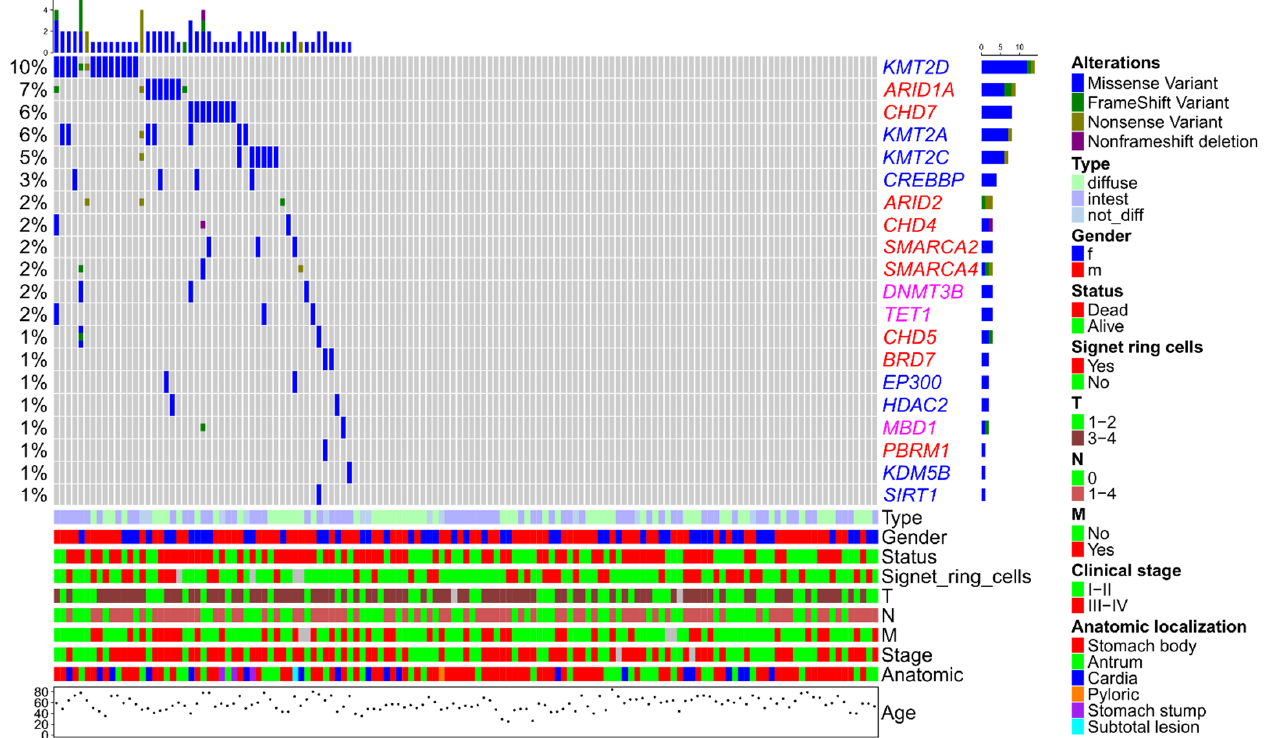
Figure 1. Spectrum of epigenetic regulation genes somatic mutations in gastric cancer. Gene names are marked according to functions of the encoded proteins: histone modifiers, blue; chromatin remodeling, red; DNA methylation/demethylation, magenta.